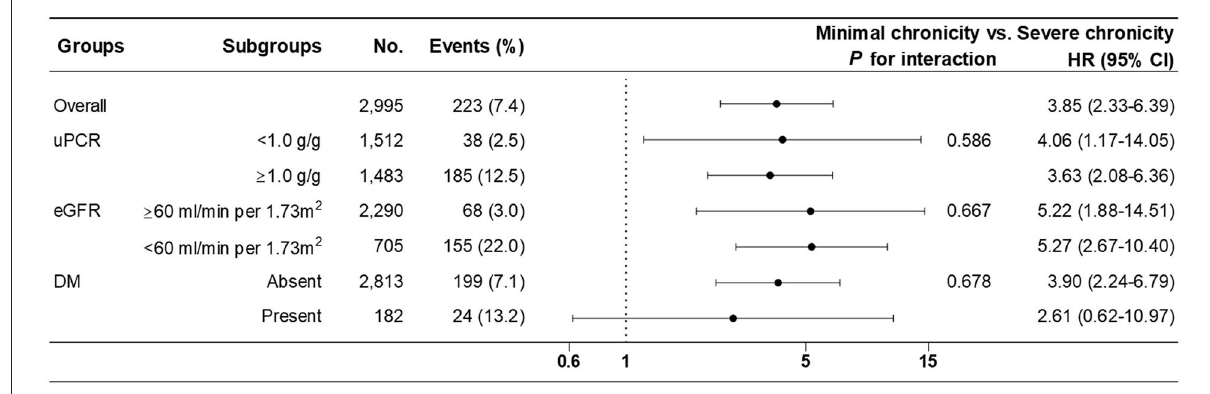
FIGURE3 Subgroup analysis of renal outcome (progression to ESRD) between minimal (reference) and severe chronicity grading from fully adjusted chronicity grading model